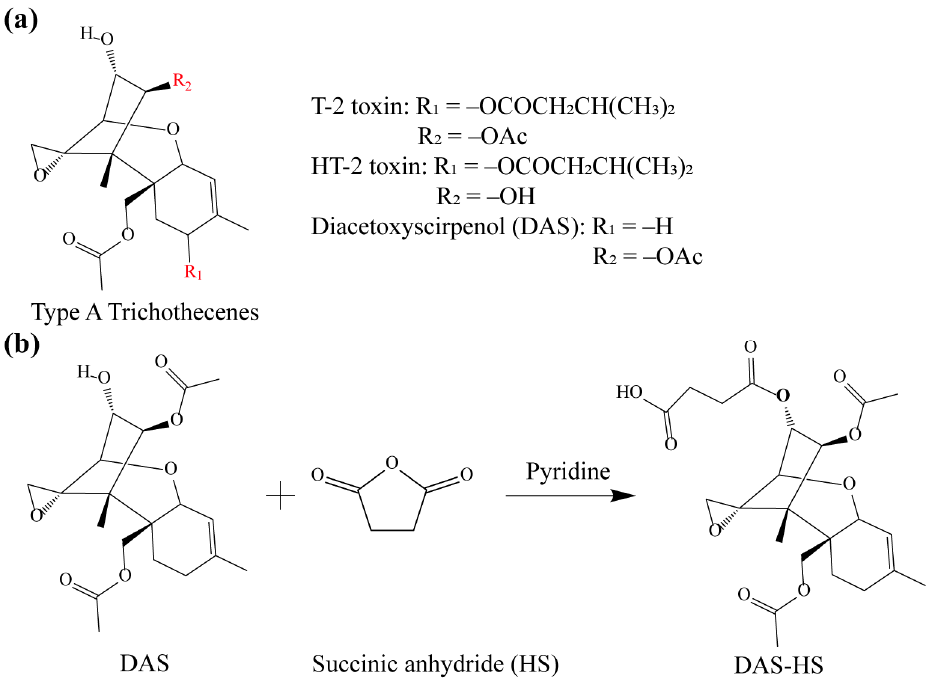
Figure 1. Structures of DAS and hapten. ( a ) Structures of type A trichothecenes, ( b ) synthetic route of DAS hapten.